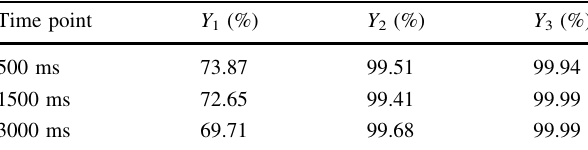
Table 2 Statistical probability within the boundaries Y 1 , Y 2 , and Y 3